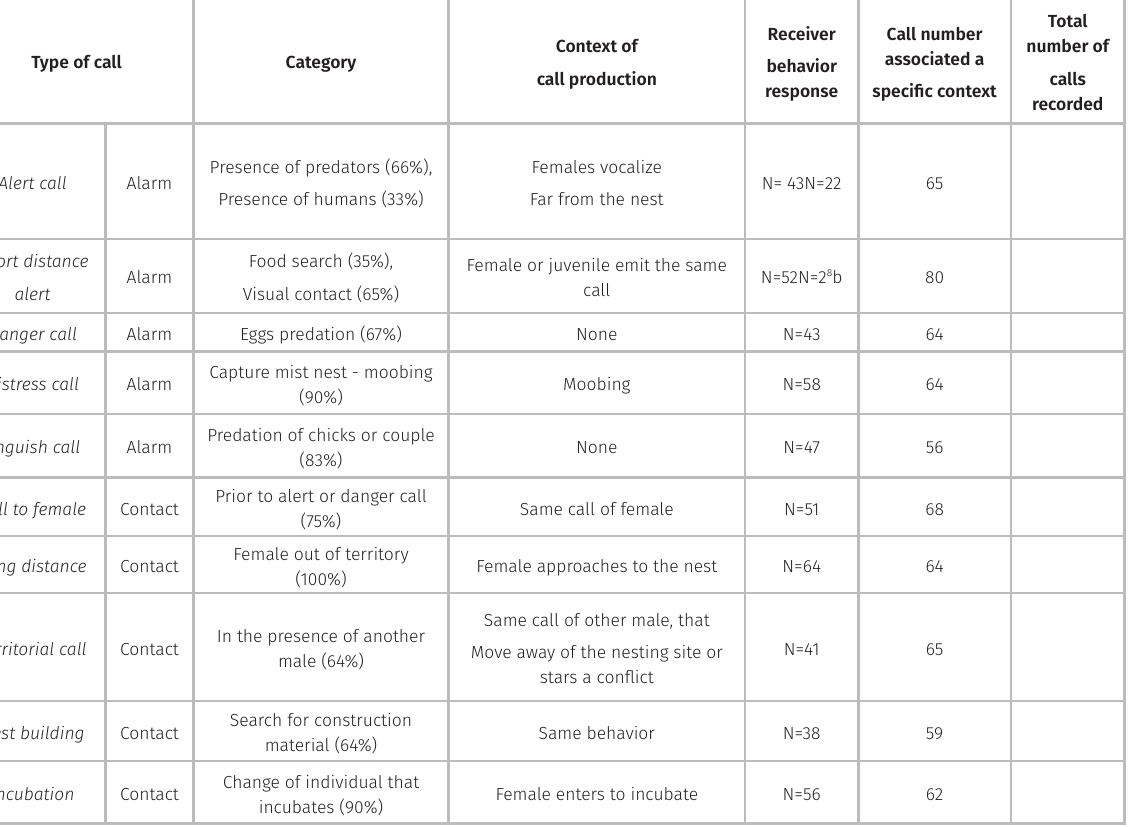
Table II. Data were collected from 50 couple of P. dumicola throughout the breeding season. Percentages (%) indicate how often a context or response was associated with a specific